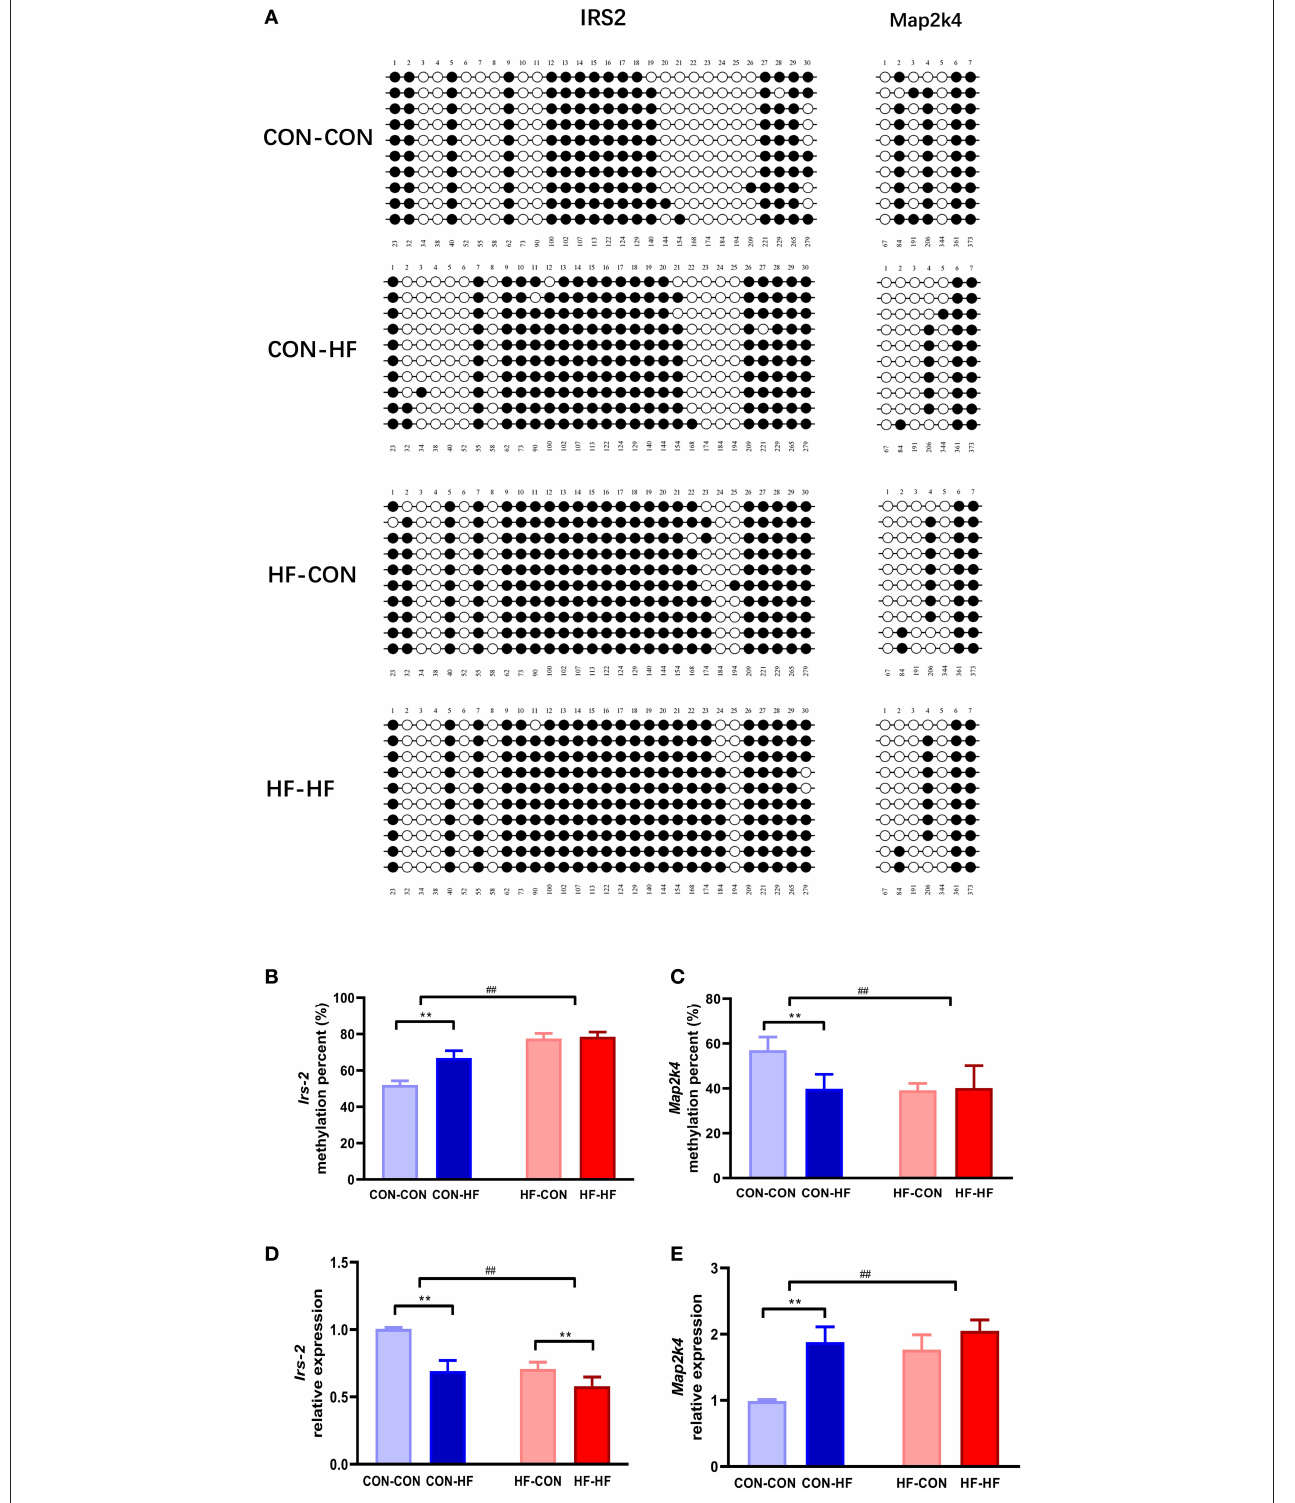
FIGURE 6 | Validation of methylation array using bisulphite sequencing. (A) Schematic diagram of bisulphite sequencing results on 30 CpG sites on Irs2 and 7 CpG on Map2k4 . Open circles indicate unmethylated CpGs, and closed circles indicate methylated CpGs. Methylation ratio of Irs2 (B) and Map2k4 (C) in different groups. Relative gene expression of Irs2 (D) and Map2k4 (E) in different groups. ** P < 0.01 offspring diet effect; ## P < 0.01 maternal diet effect. Values are mean ± SEM ( n = 10). CON-CON, control diet mother-postweaning control diet; CON-HF, control diet mother-postweaning high-fat diet; HF-CON, high-fat diet mother-postweaning control diet; HF-HF, high-fat diet mother-postweaning high-fat diet.